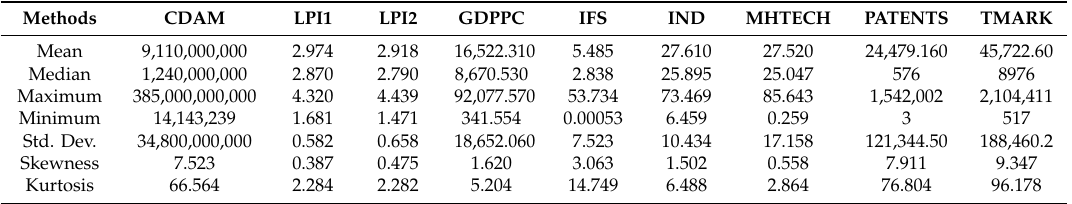
Table 3. Descriptive Statistics.